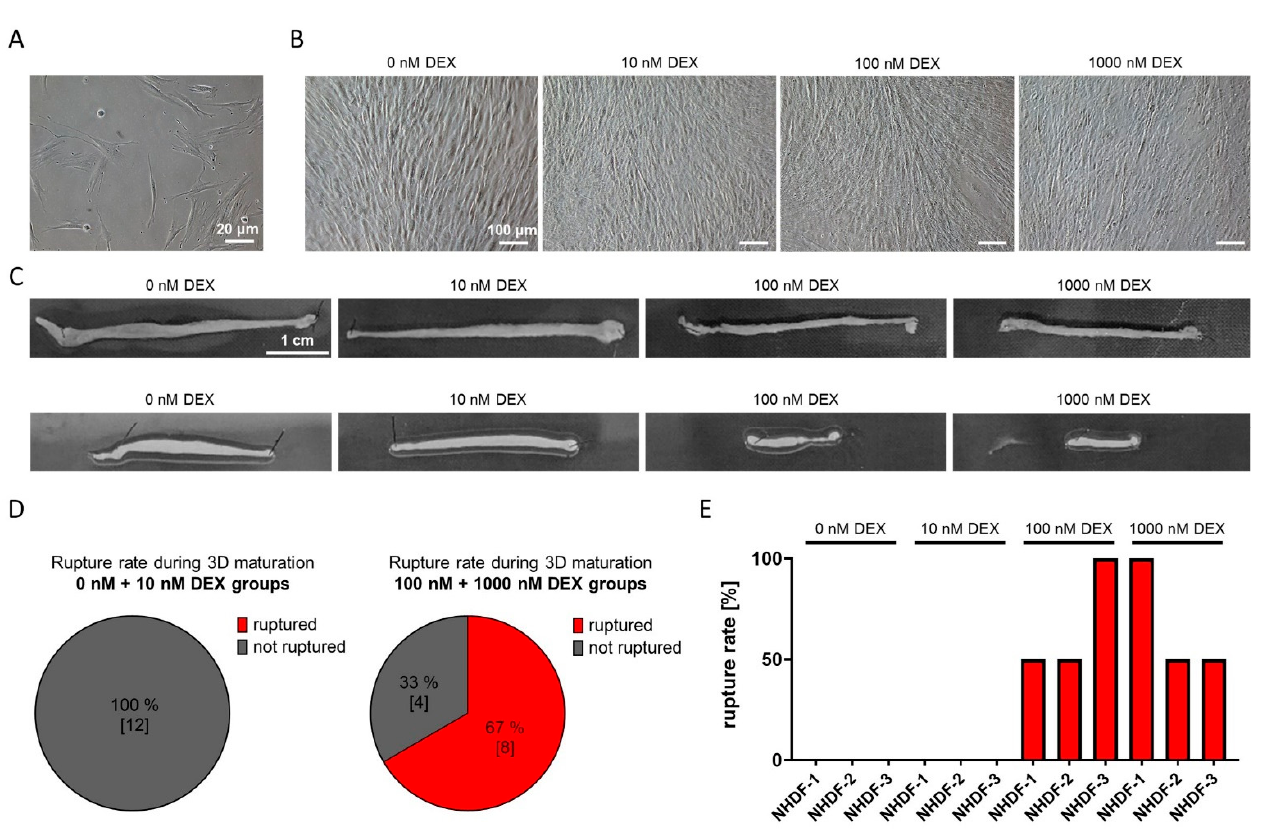
Figure 2. NHDF 2D expansion, 2D stimulation, 3D organoid formation and maturation. ( A ) Representative phase-contrast image of NHDFs at d1 of 2D expansion step. ( B ) Representative phase-contrast images of 0, 10, 100 and 1000 nM DEX NHDF organoids at d14 of 2D stimulation step. ( C ) Representative macroscopic images of NHDF organoids at d1 (upper panel) and d14 of 3D maturation step (lower panel). ( D ) Group-specific rupture rate over the course of 3D maturation for 0 and 10 nM DEX (to the left, two groups of data) and 100 and 1000 nM DEX organoids (to the right, two groups of data) (n = 3, 2 organoids/donor, [number] indicates total organoid number). ( E ) Donor-specific rupture rate (NHDF-1, -2, -3, indicates the individual donors).